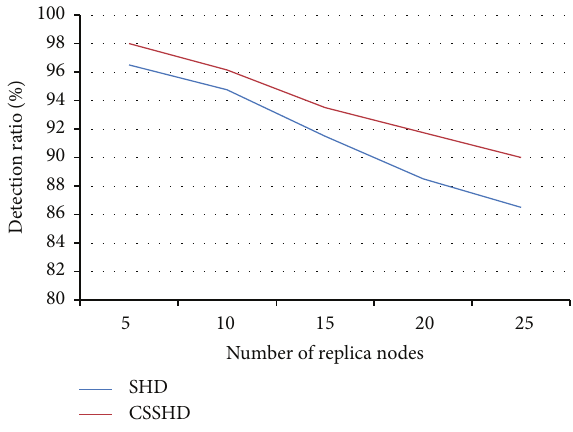
Figure 7: Graph for detection ratio.